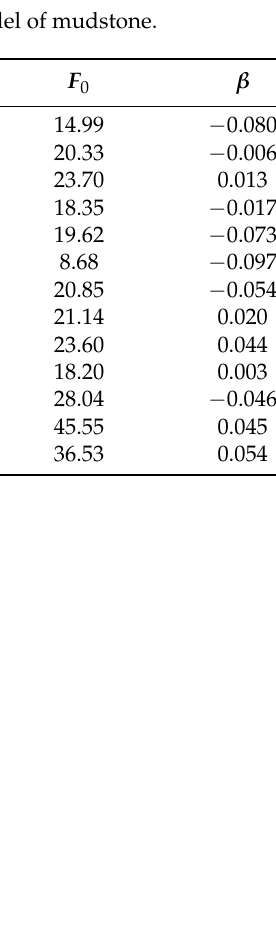
Figure 12. Comparison between the single-impact test results and the theoretical results for mudstone. It can be seen from Figures 12–15 that, although there is some discrepancy between the model curve and the test curve, the overall concordance is high. For example, the model curve cannot accurately reflect fluctuations in the test curve, especially in the initial loading stage. Under the action of a single-impact load (Figure 12), there is a certain discrepancy between the model curve and the test curve for small impact pressures. This phenomenon is mainly owing to the large dispersion of mudstone failures across impact loads, the stochasticity associated with the underlying normal distribution, and the loading pressure’s instability. As the impact pressure increases, the concordance between the test and model curves gradually increases, and the relative standard deviation is only 9% for the impact pressure of 0.6 MPa. It can be seen from Figure 15 that for the cyclic-impact pressure of 0.20 MPa, there is a small discrepancy between the test and model curves